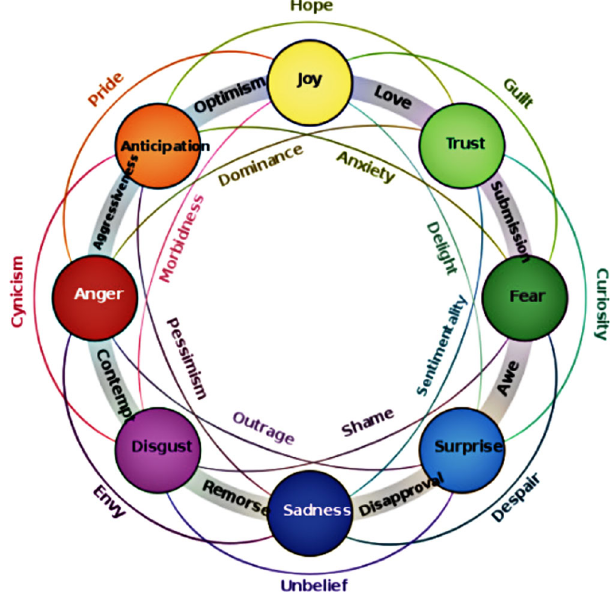
Fig. 5 Plutchik ’ s wheel of emotion (Mohsin and Beltiukov, 2019). Wheel of emotion showing the interconnection between different emotions.